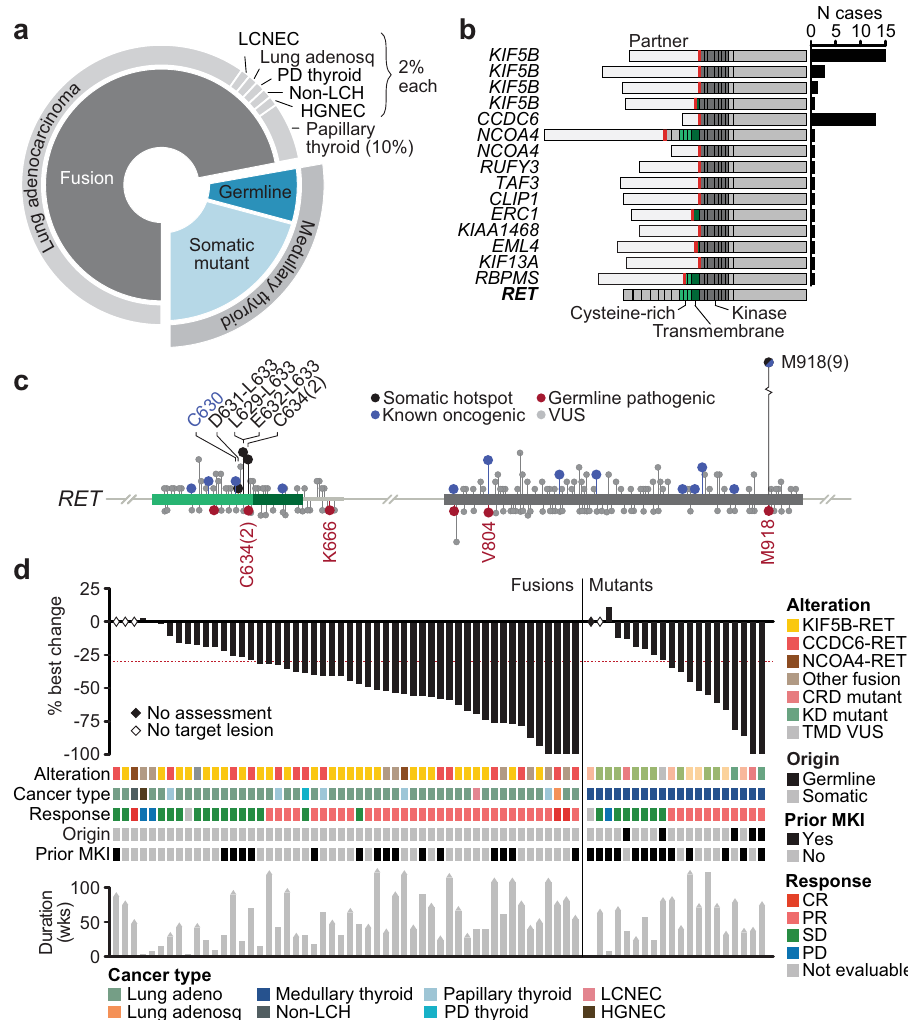
Fig. 1 RET inhibition in RET-mutant solid cancers. a The distribution of RET fusions and mutations (somatic or germline) in the study cohort by affected cancer type. PD, poorly differentiated; LCNEC, large cell neuroendocrine carcinoma of the lung; non-LCH, non-Langerhans cell histiocytosis of the skin; HGNEC, high-grade neuroendocrine carcinoma of the rectum. b The structure of all unique RET fusions in the study cohort (at right, number of affected cases). In light gray is the sequence from the indicated fusion partner. Red line demarcates fusion breakpoint. c Somatic mutations and germline variants (top and bottom, respectively) in two key regions of RET (left and right, respectively) in 31,447 prospectively sequenced human cancers. Labeled mutations correspond to enrolled patients. The mutational origin is indicated by the legend. Protein domains colored and indicated as in panel ( b ). d The clinical response of patients with RET -fusion or -mutant tumors to selpercatinib therapy is